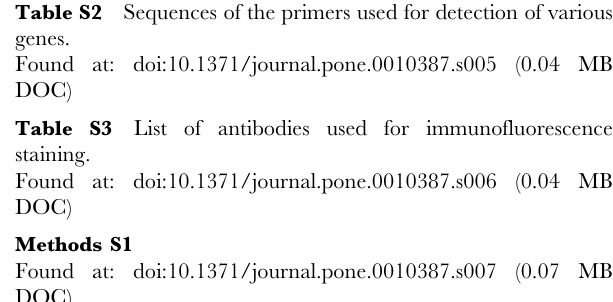
Table S2 Sequences of the primers used for detection of various genes.